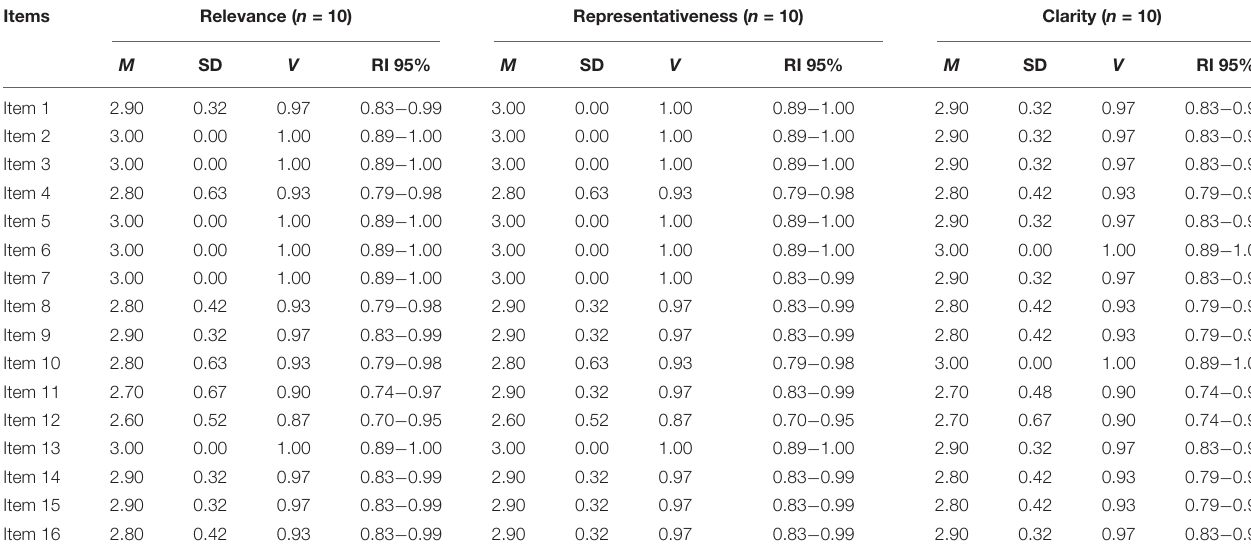
TABLE 1 | Aiken’s V to analyze relevance, representativeness, and clarity of the MoINV-U scale items.